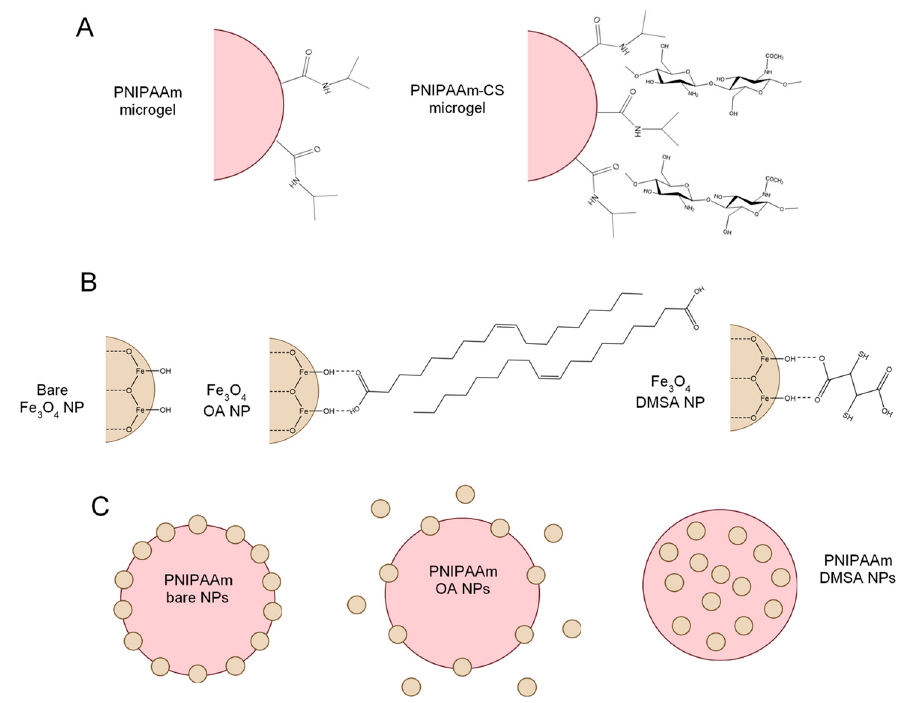
Figure 3. Schematic representation of the produced PNIPAAm and PNIPAAm-CS microgels ( A ) bare Fe 3 O 4 NPs, Fe 3 O 4 -OA NPs, and Fe 3 O 4 -DMSA NPs ( B ) and hybrid PNIPAAm microgels incorporated with the different types of NPs ( C ).